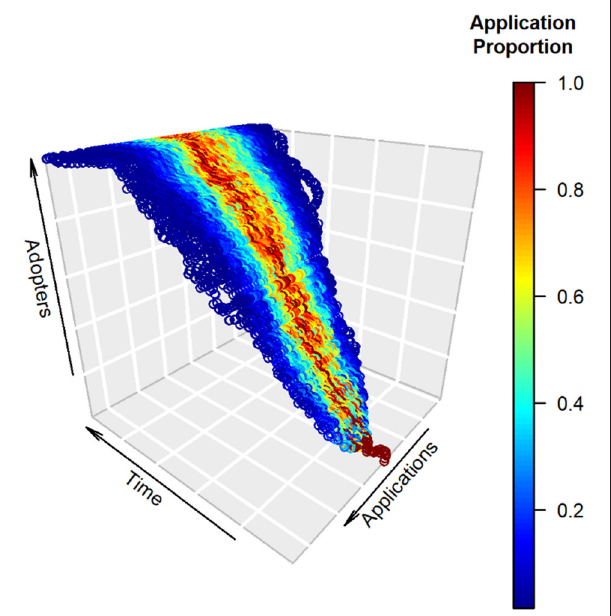
FIGURE 1 | A simple heuristic model of technological diffusion in camera trapping (CT) for which development and ingenuity lead to growth over time in both total adoption and diversification of research applications. The vertical axis depicts growth in technology adopters, which follows the S-shape characteristic of innovation diffusion (Sarkar, 1998). The horizontal applications axis depicts uses of the technology by researchers at a given point in time. Colors represent the relative fraction of uses for each application at a given time, scaled so the application with maximum use at that time receives a value of one. In this example, a core set of applications receives the bulk of uses (red), with peripheral applications receiving lower relative use (blue). The overall breadth of applications grows steadily over time, is accompanied by an expanded set of central “high use” applications, and exhibits reasonable temporal constancy in those applications deemed core vs. peripheral (i.e., stationarity of mean application). Our formulation assigns each adopter in a time step to the application of one of the current CT practitioners with equal probability. It thus allows for interpersonal effects; differential influence of CT researchers also could be modeled in this framework using unequal weights ( Magsamen-Conrad and Dillon, 2020). The model assumes: (1) logistic growth with a capacity of 1,000 adopters, and (2) the possibility of application diversification at each time step according to a symmetric trinomial distribution with fidelity (probability = 0.5) to the adopter’s current application and equal probability (0.25) of adoption of applications immediately adjacent to the current application. Many alternative mechanisms of diffusion could be formulated; a second simple example is provided online ( Supplementary Figure 1 ). In our review, we measured adoption by number of articles published and considered diversification for three categories of CT applications: research topics, taxonomy, and